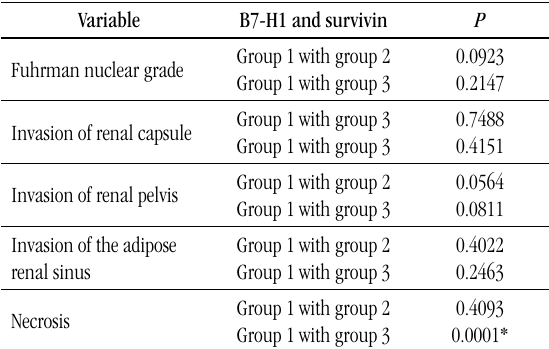
tABLE 2 – Traditional prognostic factors identified at anatomopathological examination and their correlation with the three groups formed according to the immunohistochemical expression of survivin and B7-H1 in a sample of 98 cases of renal cell carcinoma, using the chi-square